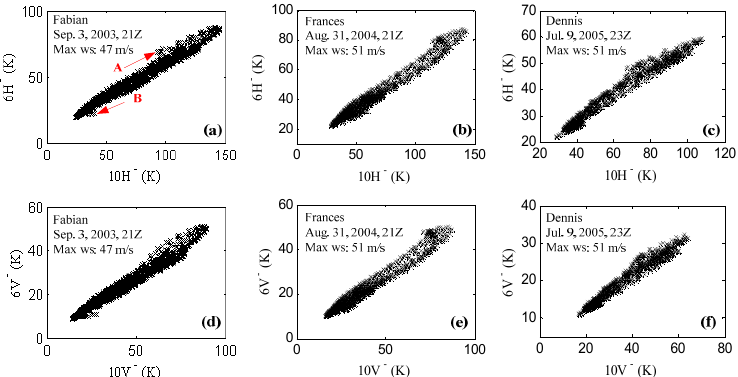
Figure 6. Relationships of WindSat 6H ¯ and 10H ¯ for three hurricanes: ( a ) Fabian (2003); ( b ) Frances (2004); and ( c ) Dennis (2005). Relationships of WindSat 6V ¯ and 10V ¯ for three hurricanes: ( d ) Fabian (2003); ( e ) Frances (2004); and ( f ) Dennis (2005).